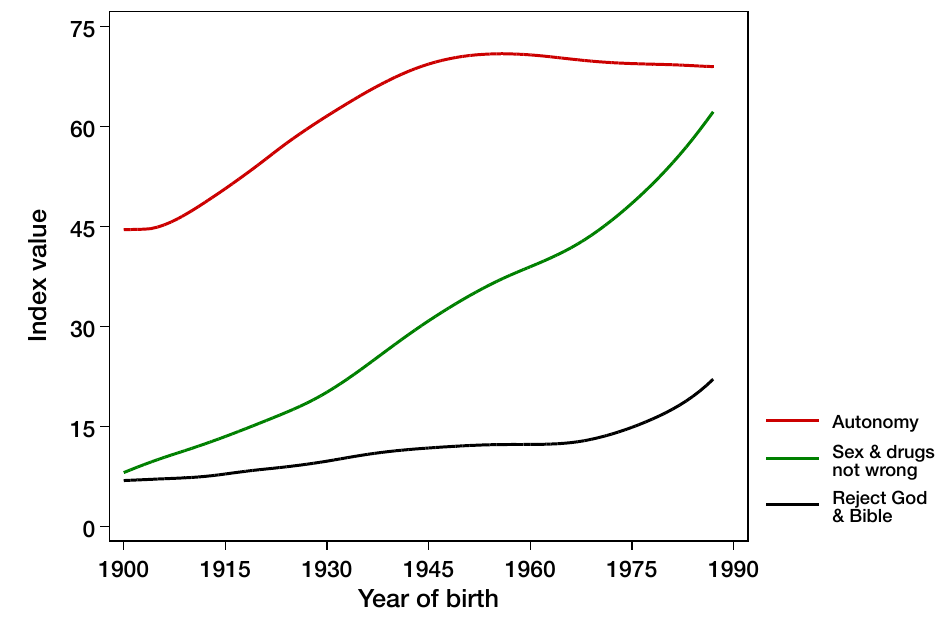
Figure 6: Indices of Religious Disbelief, Counter-cultural Attitudes, and Autonomy by Year of Birth: Persons, 25 years old and